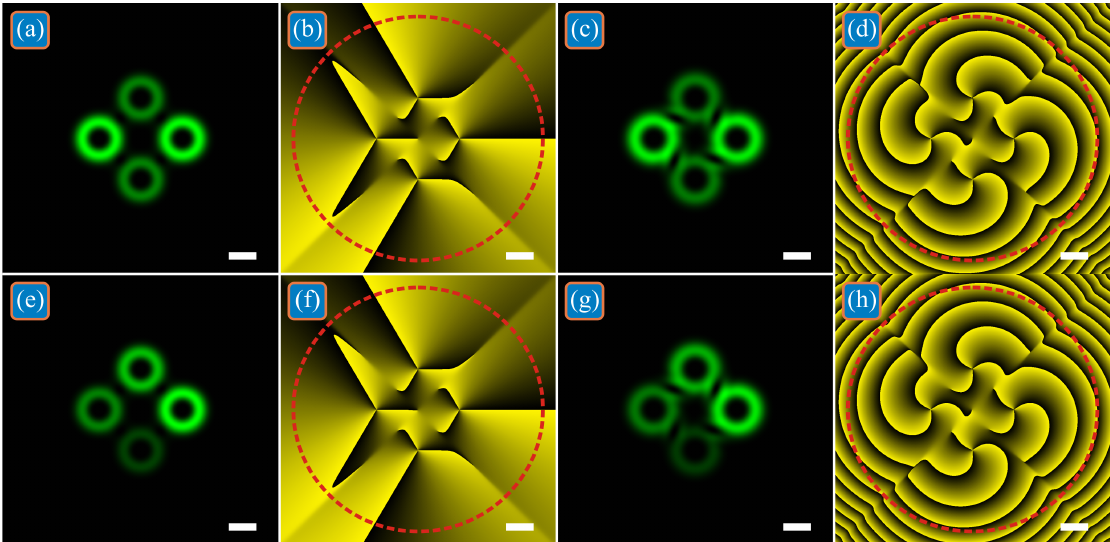
Figure 4. Intensities ( a , c , e , g ) and phases ( b , d , f , h ) of two superpositions of off-axis single-ring LG beams with different powers in the initial plane ( a , b , e , f ) and at the half of the Rayleigh distance ( c , d , g , h ). The superposition coefficients are c 1 = c 3 = 1, c 2 = c 4 = 1/2 1/2 ( a – d ) and c 1 = 1, c 2 = 3 1/2 /2, c 3 = 2 1/2 /2, c 4 = 1/2 ( e – h ).